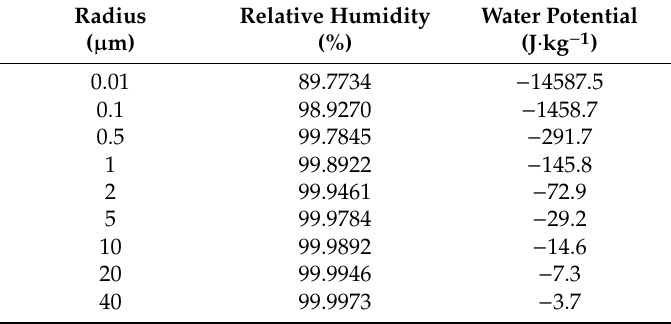
Table 1. The relative humidity and water potential at which capillary condensation occurs in cylindrical pores with di ff erent radii at 20 ◦ C. The relative humidity was calculated from Equation (1) with r 1 = r 2 = r . For conversion of relative humidity to water potential, see Equation